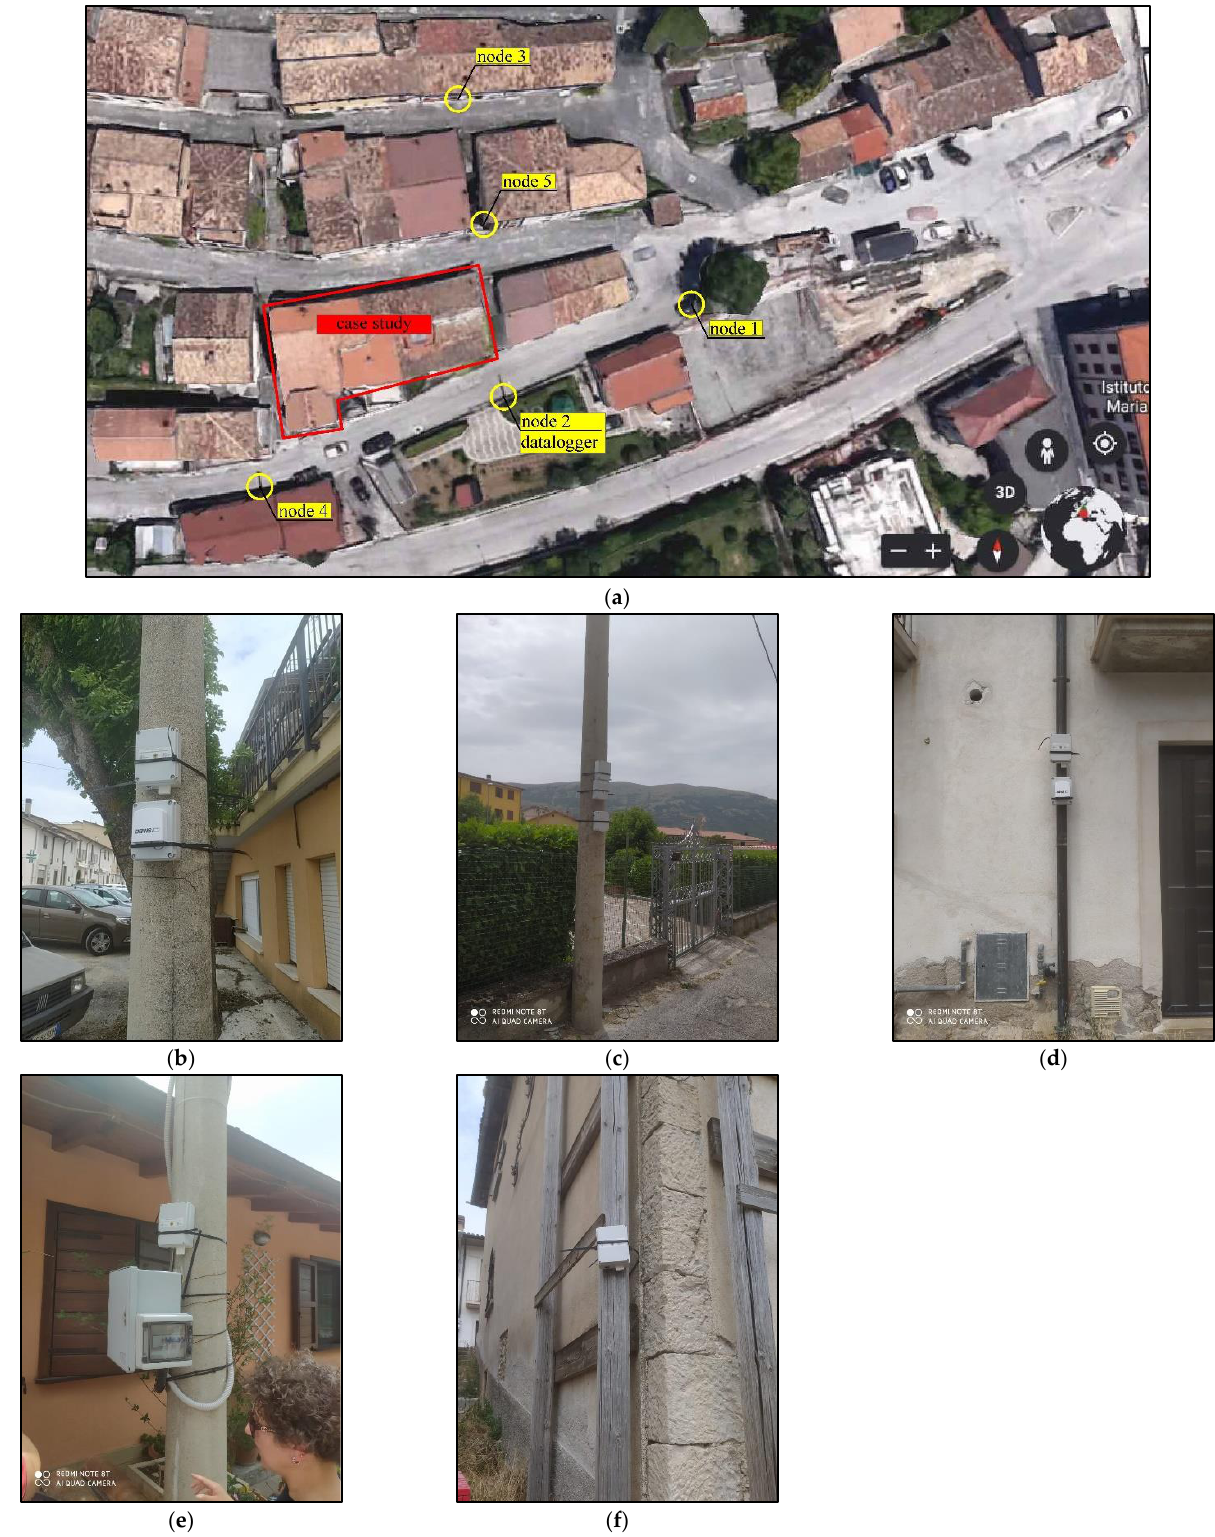
Figure 8. ( a ) Plan of the area; ( b ) node installation 1; ( c ) node 2 and data logger installation; ( d ) node installation 3; ( e ) node installation 4; ( f ) node installation 5.